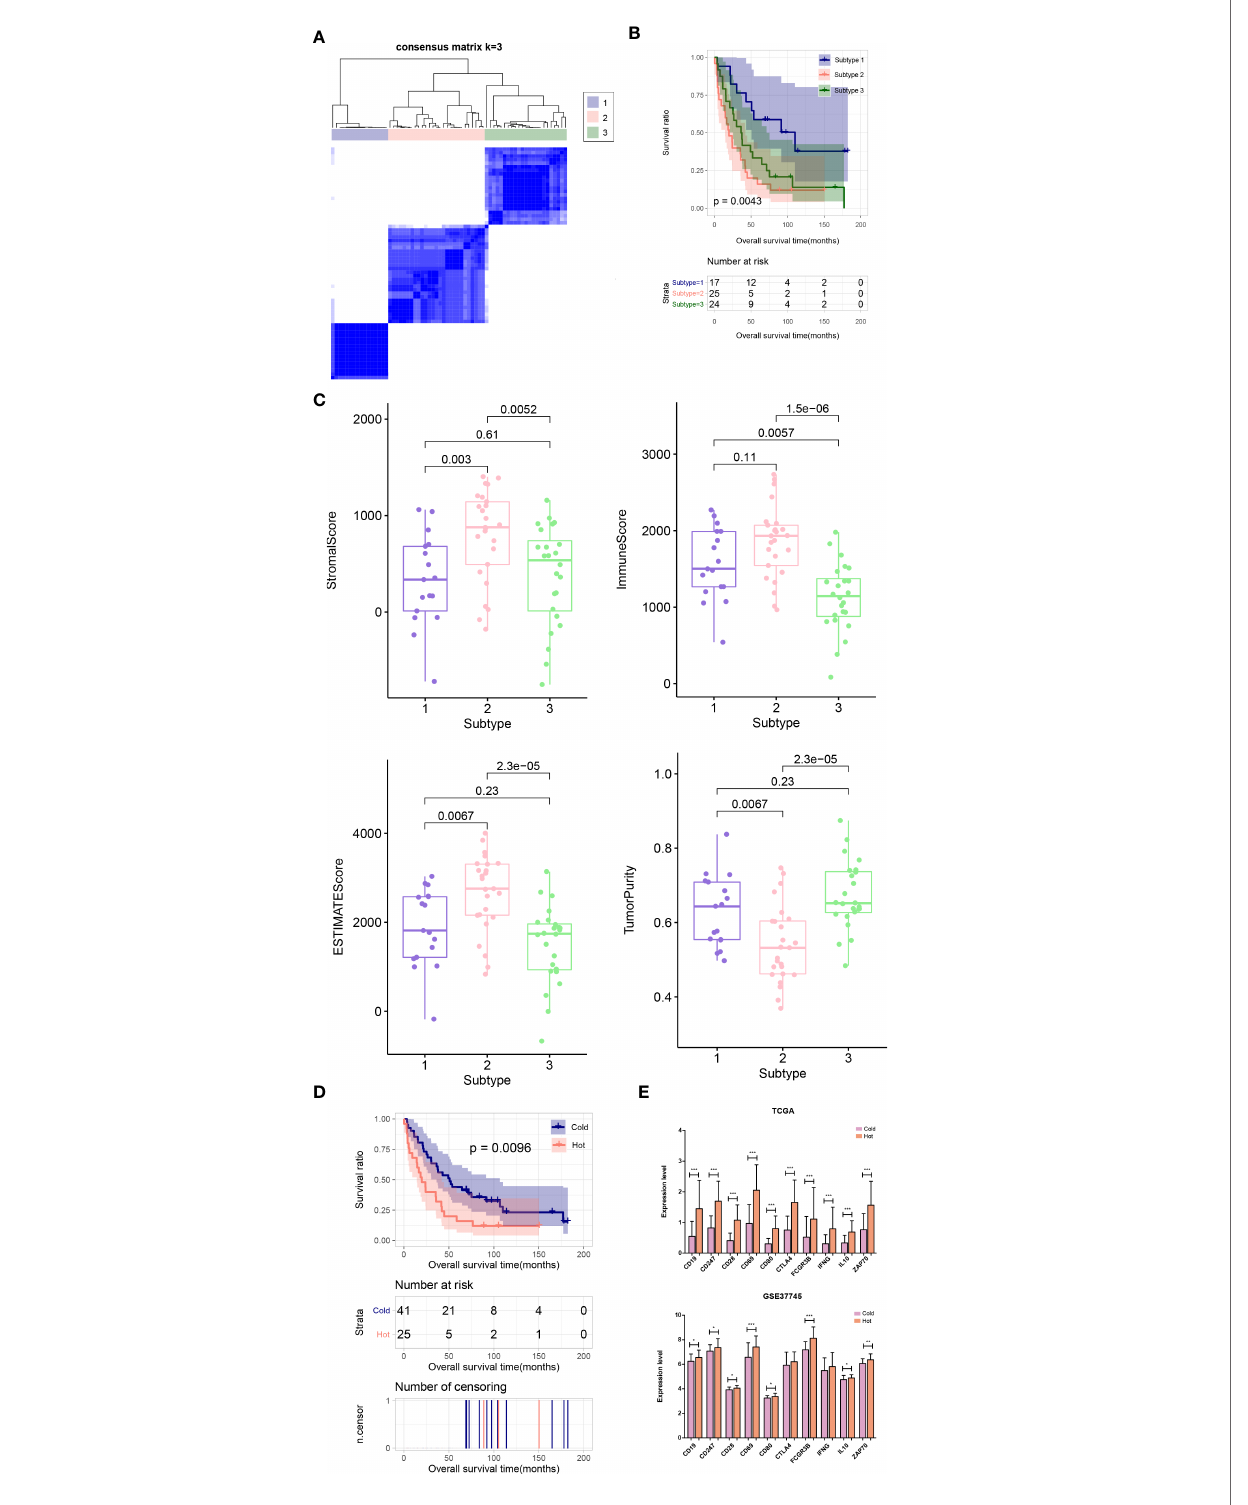
FIGURE 8 | (A) Sample subtype analysis cluster diagram in the validation set. (B) KM survival curves of different subtypes in validation set. (C) Comparison of the distribution of stroma score, ESTIMATE score, immune score, and tumor purity in different subtypes in validation set. (D) KM curves associated with survival outcomes in the Hot and Cold sample groups in validation set. (E) Expression level distribution of top10 hub genes in Cold and Hot tumor samples in the TCGA training set and validation dataset GSE37745. *P < 0.05; **P < 0.01; ***P <